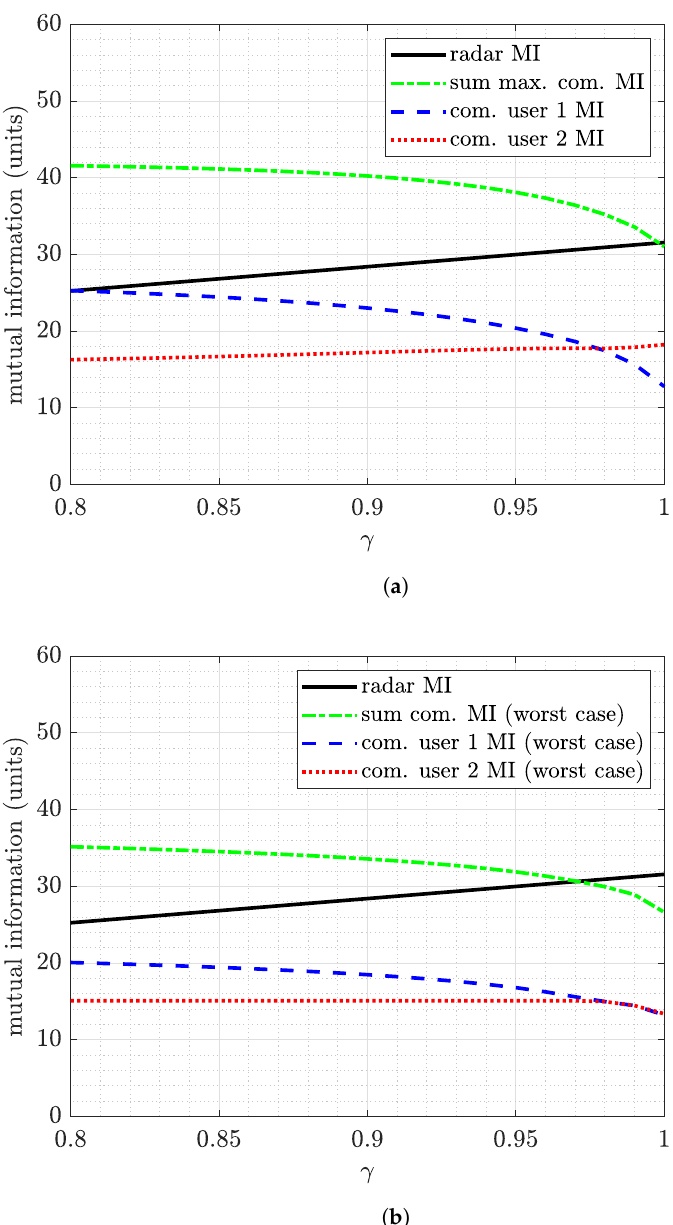
Figure 8. Cooperative power allocation for varying γ . ( a ) Sum communication MI maximization. ( b ) Worst-case communication MI